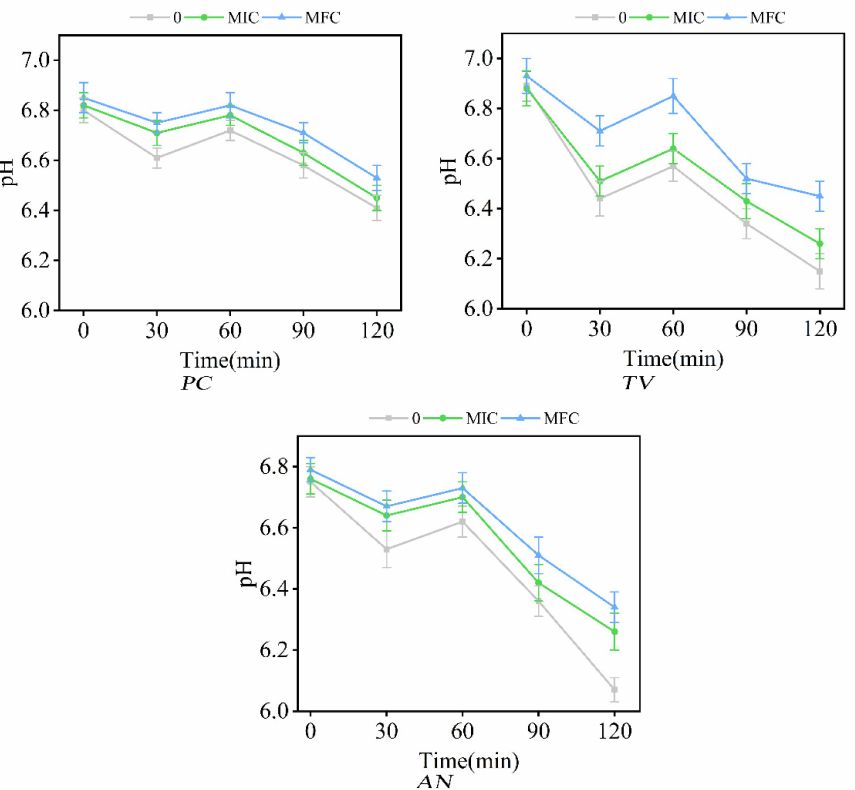
Figure 8. Effect of dodecylpyridinium chloride on pH of extracellular fluid of bamboo mycorrhizal fungi (control: 0; treated group: MIC,